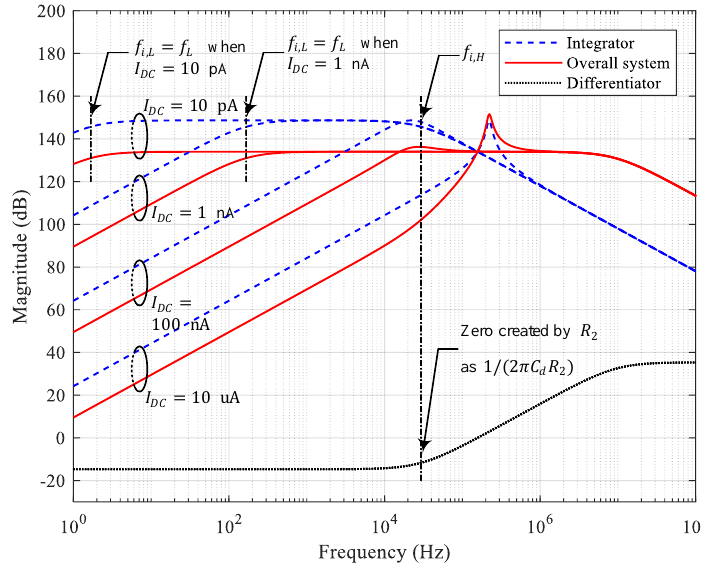
Figure 3. Transfer functions of the integrator, differentiator, and the overall system without C 2 for I dc = 10 pA, 100 nA, 1 nA, and 10 uA, where C µ = 1 pF, C µ , c = 1 pF, G c = 50, C f = 0.2 pF, C d = 1 nF, C c = 8.51 pF, R d = 2 k Ω , R 2 = 8.16 k Ω , C 1 = 10 nF, and R 1 = 100 k Ω